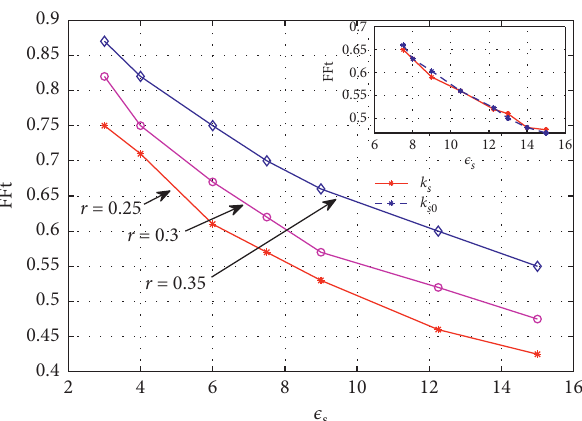
Figure 3: Frequency ( k ) calculated numerically for different values of ε � 1 for radius r � 0 . 25 , 0 . 3 and 0.35. It is seen s s in a slab of holes ε h that for a greater contrast of the dielectric constant, the value of the k s decreases, until reaching the minimum value in k s ∼ 0 . 43 for r � 0 . 25 and the maximum k s ∼ 0 . 87 for r � 0 . 35. The graph inside the panels show the case of k s for r � 0 . 3 where the red curve is the experimental data, while the blue one shows the results following from the equation ε p � ( ε s ( V s − V c ) − ε h V c ) / ( V s + V c ) . See more details in text.